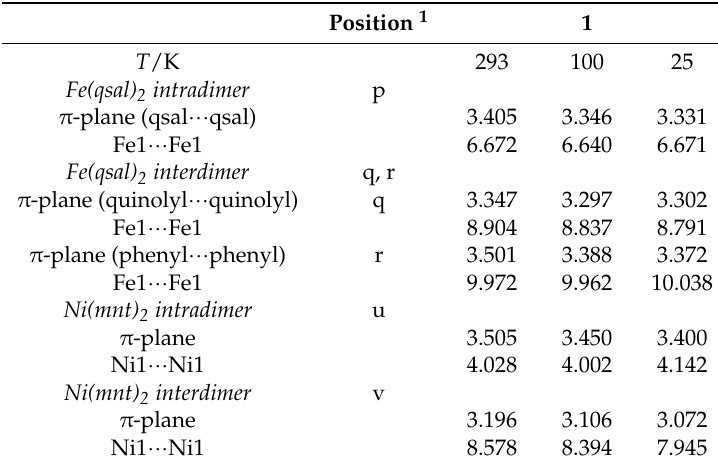
Table 4. Selected intermolecular distances (Å) in 1 .